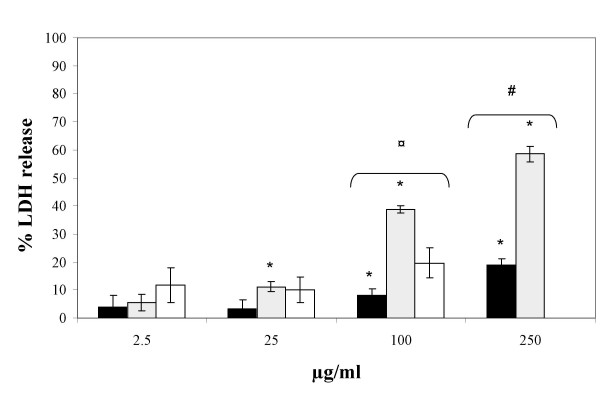
Cytotoxicity of A549 cells exposed to SRM2975 (solid bars), SRM1650 (hatched bars) and ASPM (open bars). The 100% maximum LDH release is obtained by treatment of cell cultures with Triton X-100, whereas the baseline LDH release in untreated cell cultures is 0%. Bars denote the mean ± SEM; (n = 3). * Statistically significant compared to control p < 0.05 (Kruskal-Wallis test). # Higher level of LDH release of SRM1650 compared to SRM2975 (p < 0.01, Mann-Whitney U test). ¤ Higher level of LDH release of SRM1650 compared to SRM2975 and ASPM (p < 0.05, Kruskal-Wallis test).